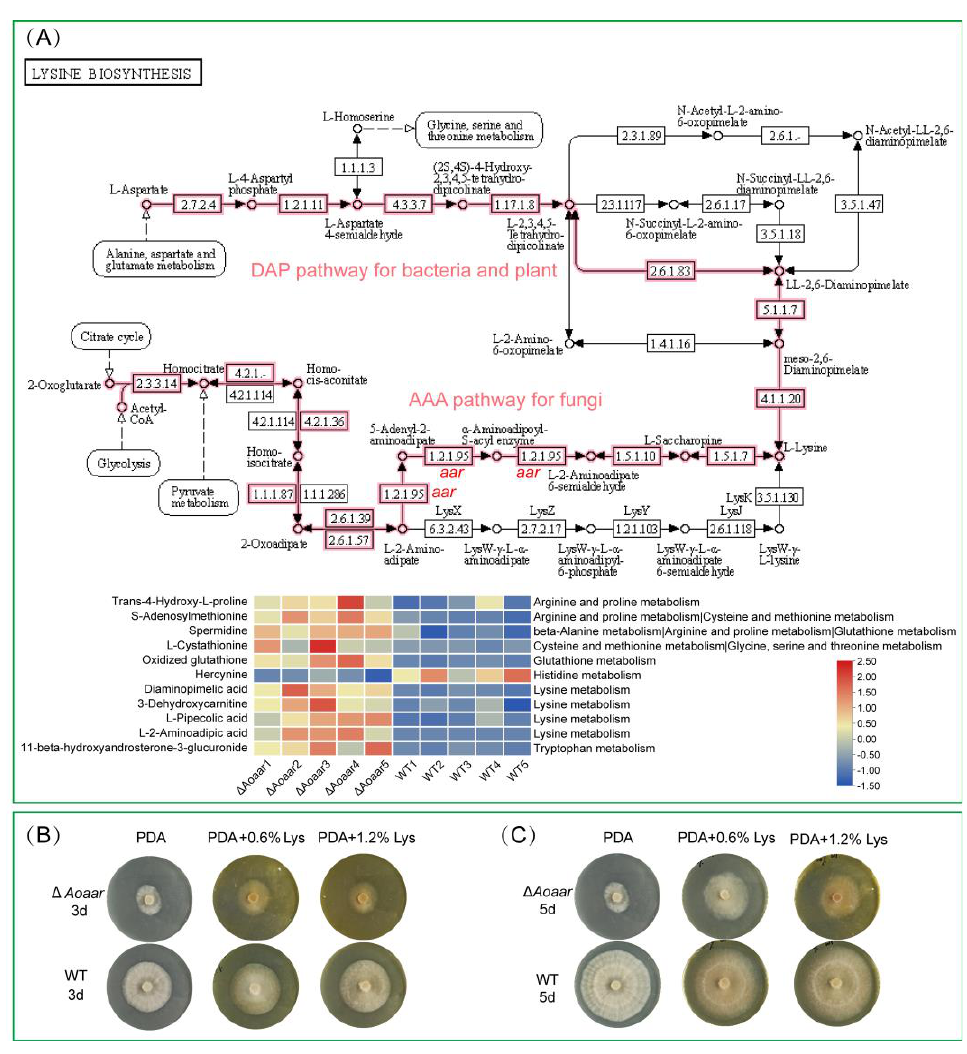
Figure 6. The effect of Aoaar knockout on the lysine biosynthesis pathway. ( A ) Diagram showing pathways for lysine biosynthesis in bacteria and plants (DAP pathway), and in fungi (AAA pathway). The heatmap shows the abundance of metabolites (left) involved in amino acid-related metabolic pathways (right). ( B ) A comparison of the effects of lysine supplementation on the growth of WT and the Aoaar knockout strain at day 3. ( C ) A comparison of the effects of lysine supplementation on the growth of WT and the Aoaar knockout strain at day 5. aar, α -aminoadipate reductase .